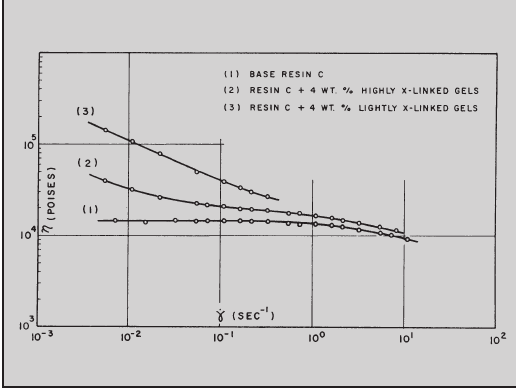
Figure 7: Effect of gels on flow curves